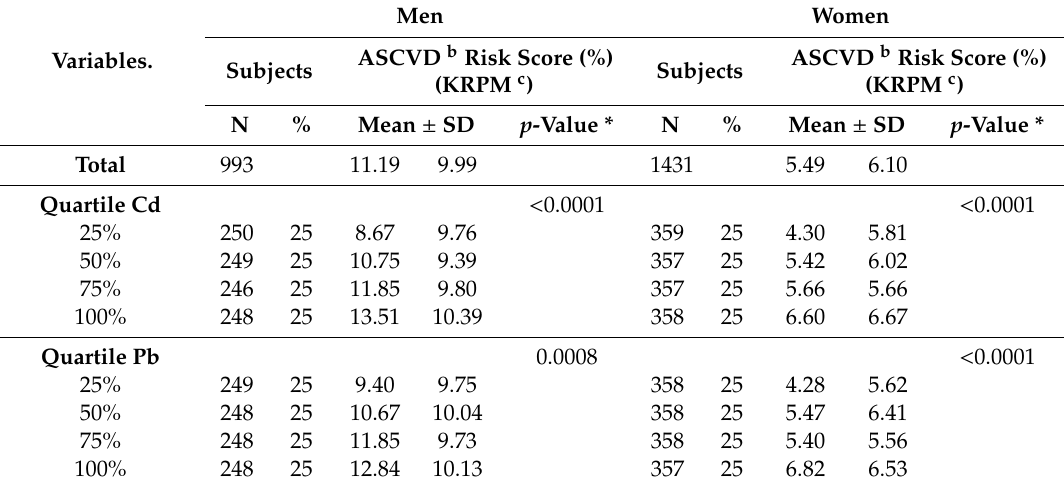
Table 1. General characteristics of the study population at the 2016–2017 baseline.